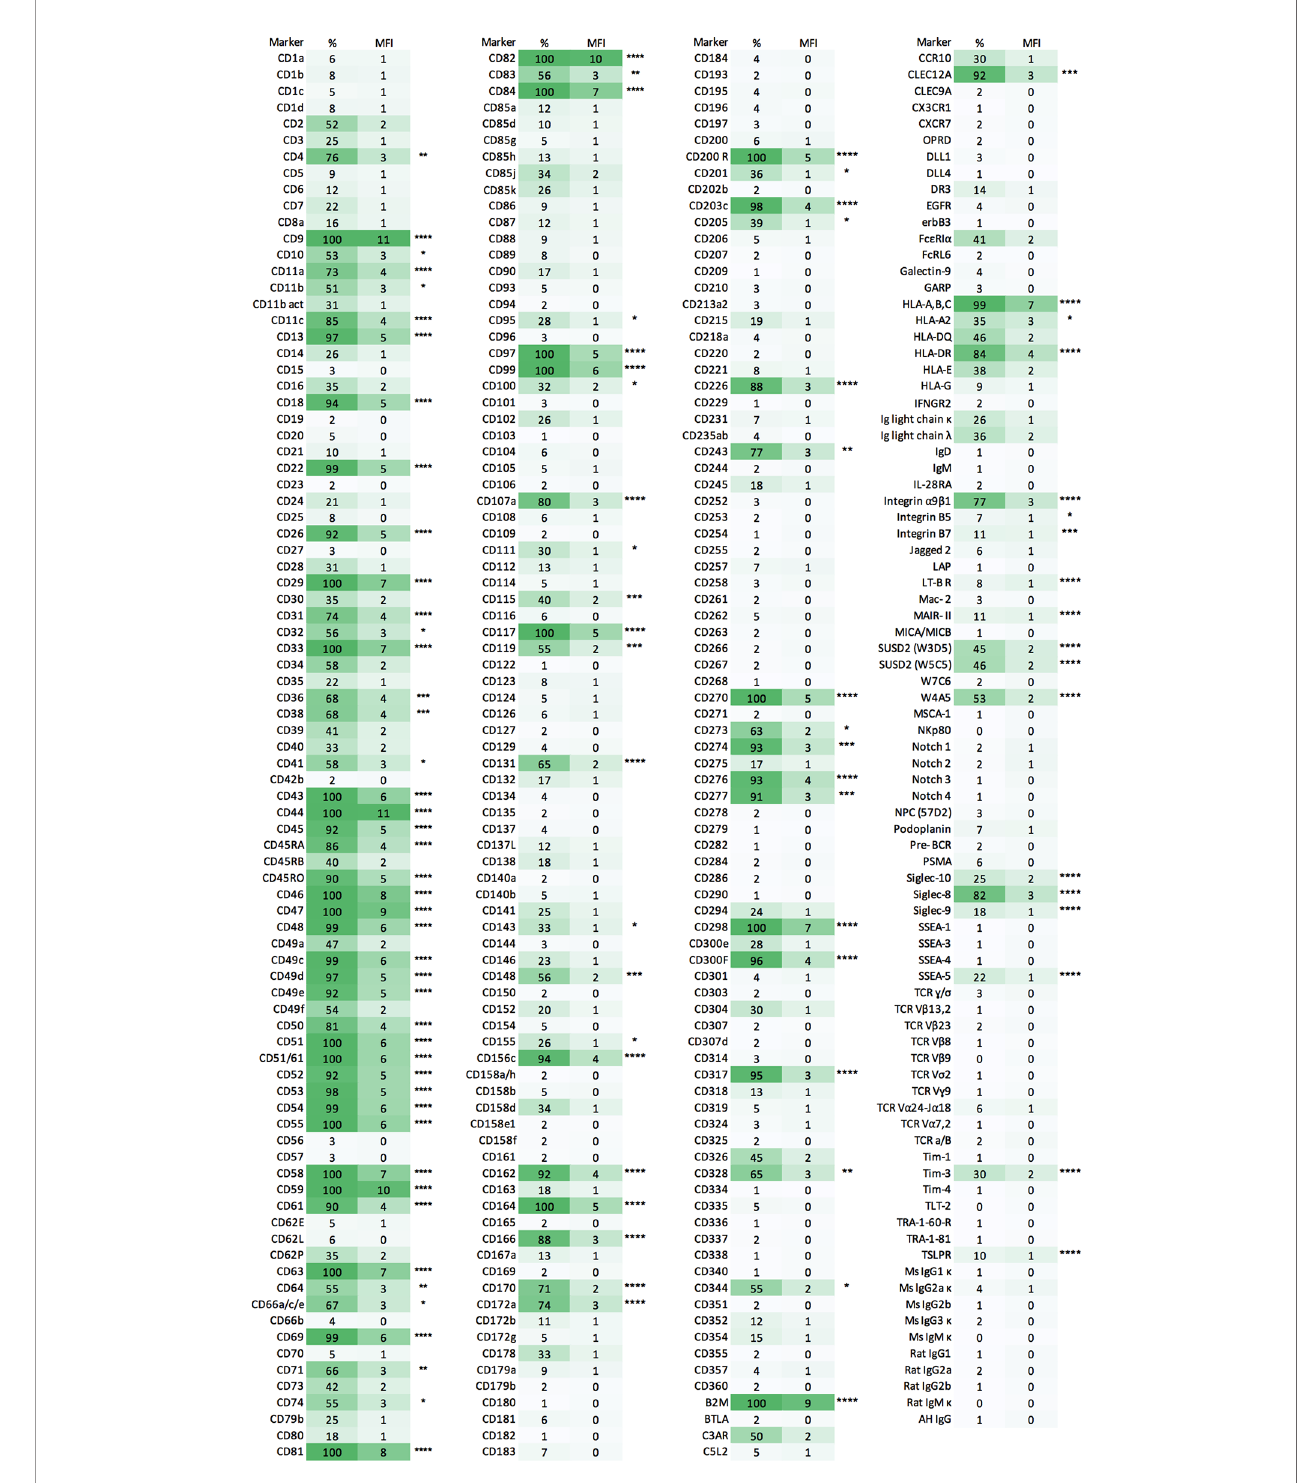
FIGURE 2 | Expression of cell-surface antigens on HLMCs. HLMCs stained with the LEGENDScreen human cell screening kit. Mast cells were gated as CD45 + CD14 low CD117 high cells. Shown are the percent positive (%) for each marker, the MFI (normalized to the plate-matched FMO control and log 10 transformed) and the stars represents the signi fi cance of the MFI of the marker compared to that of the FMO control (one-way ANOVA with Dunnett ’ s multiple comparisons test). *p < 0.05, **p < 0.01, ***p < 0.001, ****p < 0.0001. n =